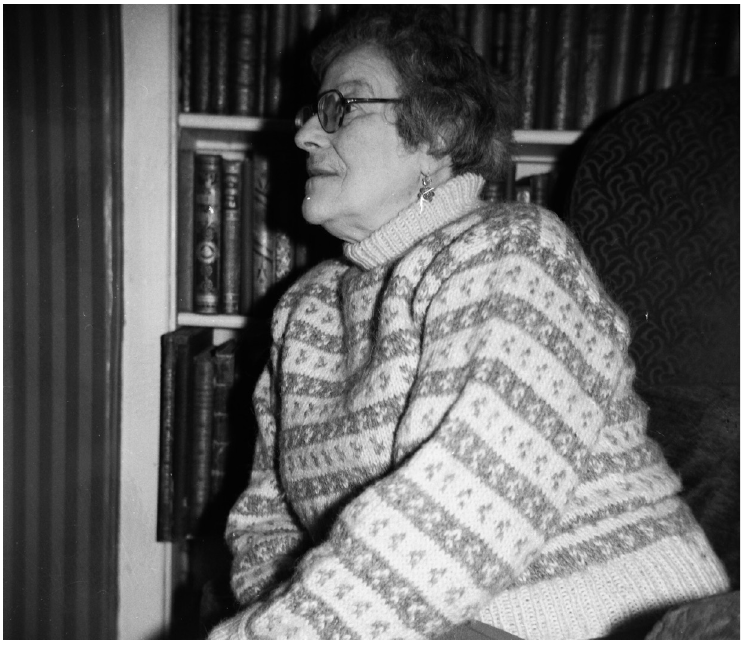
Figure 6 Sylvia Townsend Warner at the Old Rectory, Litton Cheney. Image courtesy of the Estate of Reynolds and Janet Stone.